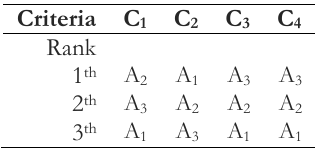
Table 8. Matrix of priorities of each alternative in relative to each of the